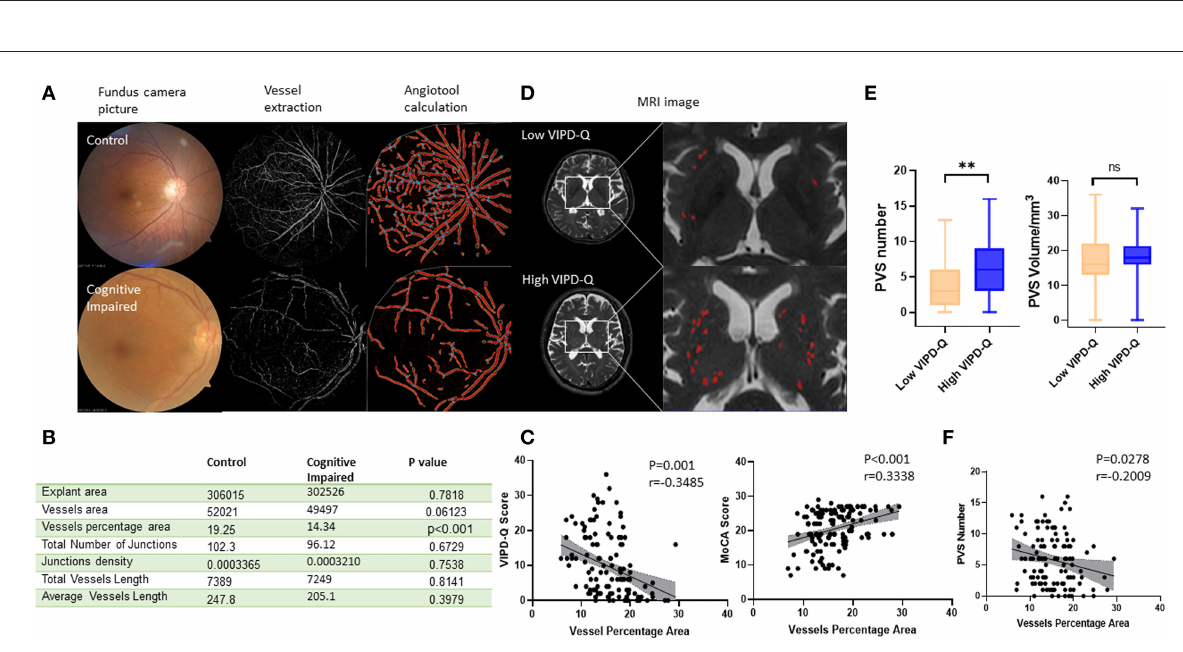
FIGURE4 Vascular density in ocular density predicted PVS number and cognitive status in PD. (A) Typical procedure for calculating vascular density in groups with or without cognitive impairment. (B) A table of vascular-related parameters in ocular fundus analyzed by angiotool. (C) The vessel percentage area was correlated with VIPD-Q and MoCA scores. (D) Representative MRI images for VIPD-Q high and low groups. (E) PVS count showed a discrepancy between VIPD-Q groups. (F) The vessel percentage area was correlated with PVS counts. ** p < 0.01, *** p < 0.001,and r = Pearson r. MRI, magnetic resonance imaging; PD, Parkinson’s disease; PVS, perivascular spaces; VIPD-Q, Visual Impairment in Parkinson’s Disease Questionnaire; MoCA, Montreal Cognitive